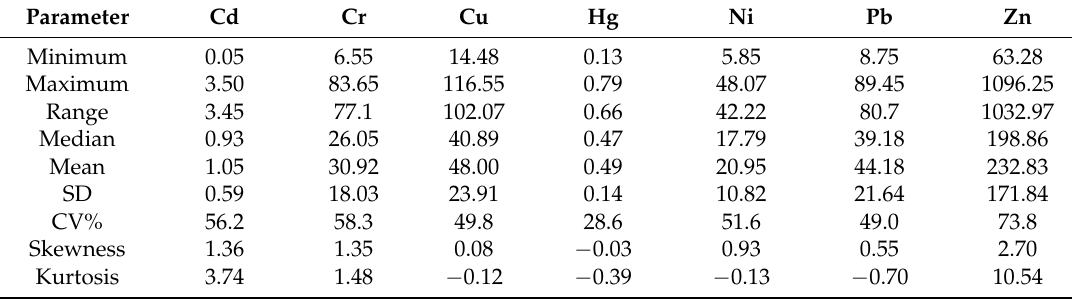
Table 2. Summary of heavy metal concentrations in mosses across Taizhou (mg · kg − 1 , DW)